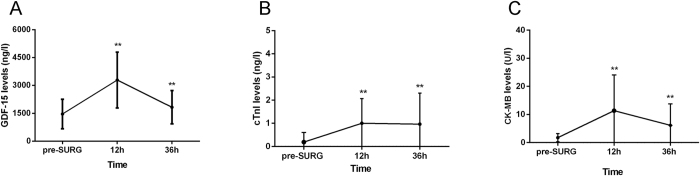
Time course of plasma GDF-15 levels (A), cTnI levels (B) and CK-MB levels (C) given as the mean ± SD. On average, GDF-15 levels, cTnI levels and CK-MB levels exhibited a 2.5- to 5-fold increase in plasma samples collected 12 h after OPCAB, respectively. **Significantly different (p < 0.01) between time-point and pre-SURG levels (One way repeated measures ANOVA).